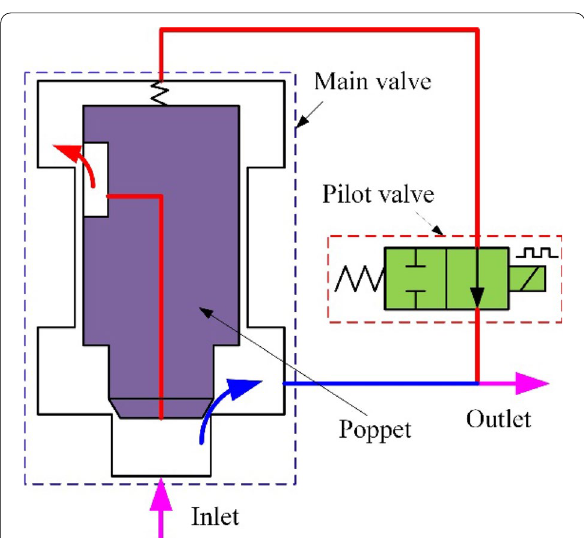
Figure 24 Digital Valvistor valve designed by Li et